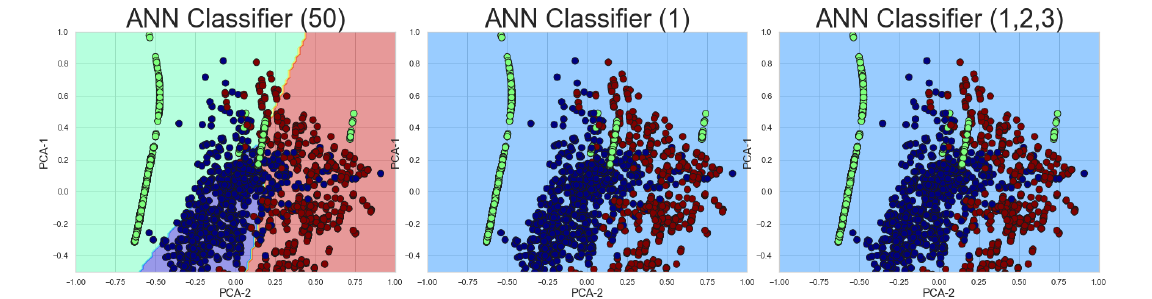
Figure 14. Fault Visualization Plot for the Aluminum Electrolytic